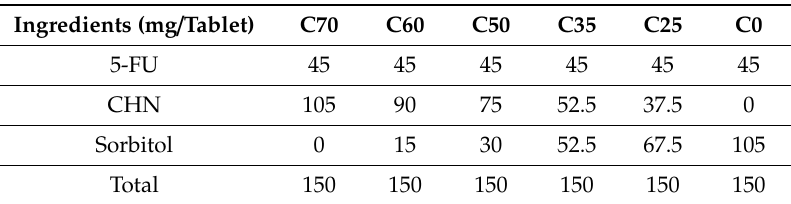
Table 3. Composition of Blend 2 *